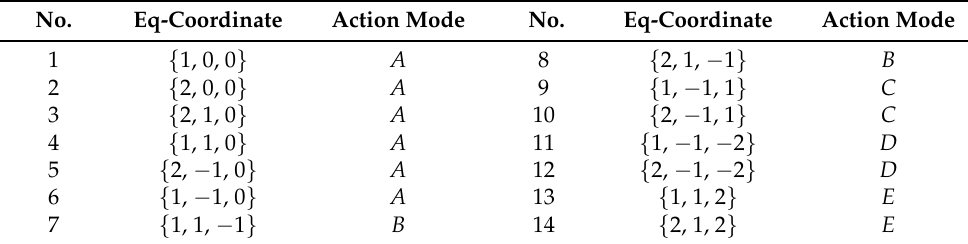
Table 1. Determination of effective actions of the